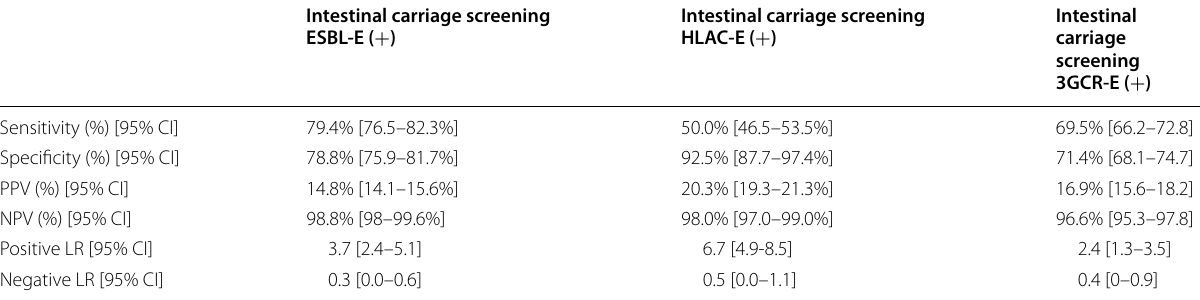
LR: likelihood ratio. Sensitivity, specificity, positive predictive value, negative predictive values are expressed as percentage [95% CI]. Likelihood ratios are expressed as absolute value [95% CI]. ESBL-E, Extended-spectrum beta-lactamase producing Enterobacterales ; HLAC-E, high-level expressed AmpC